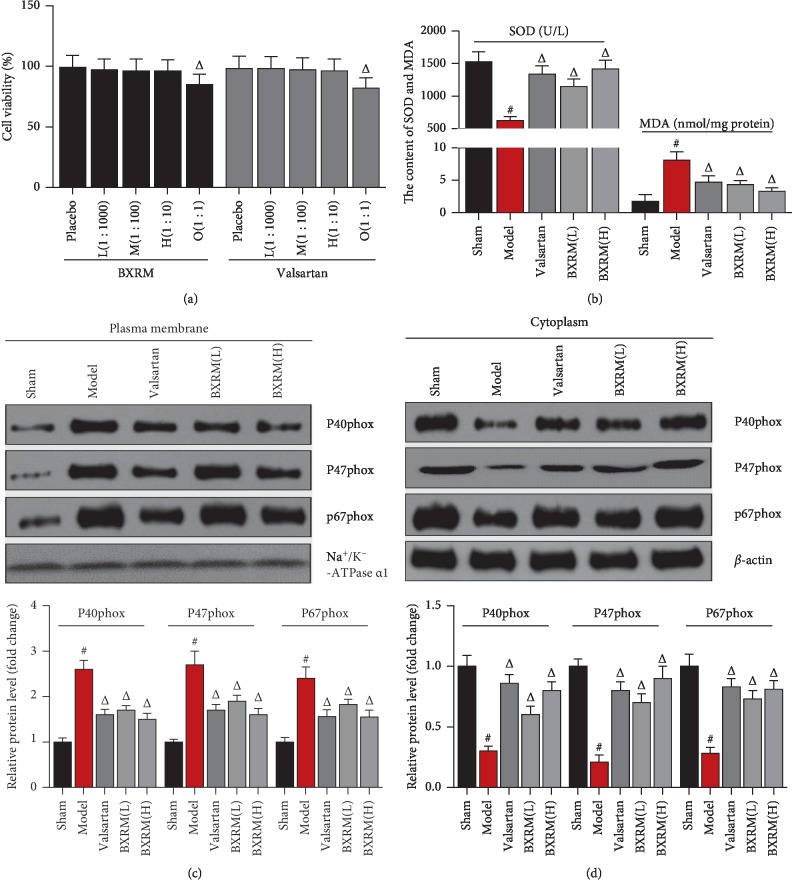
Effect of Granule of BU-XIN RUAN-MAI-containing serum on antioxidation and energy metabolism in angiotensin II-stimulated HUVEC cells. (a) The effect of Granule of BU-XIN RUAN-MAI on HUVEC cell viability. Data shown are mean ± SD; #P < 0.001 versus the placebo group. (b) Effect of Granule of BU-XIN RUAN-MAI-containing serum on the SOD content and MDA content in angiotensin II-stimulated HUVEC cells; data shown are mean ± SD; #P < 0.001 versus the sham group and ΔP < 0.05 versus the model group. (c) Effect of Granule of BU-XIN RUAN-MAI-containing serum on energy metabolism indicators (P40phox, P47phox, and P67phox) at the cell membrane detected by western blot in angiotensin II-incubated HUVEC cells and the corresponding semi-quantitative analysis was based on optical density with ImageJ software; data shown are mean ± SD; #P < 0.001 versus the sham group and ΔP < 0.05 versus the model group. (d) Effect of Granule of BU-XIN RUAN-MAI-containing serum on energy metabolism indicators (P40phox, P47phox, and P67phox) in the cytoplasm detected by western blot in angiotensin II-incubated HUVEC cells, and the corresponding semi-quantitative analysis was based on optical density with ImageJ software; data shown are mean ± SD; #P < 0.001 versus the sham group and ΔP < 0.05 versus the model group. The data are representative of three independent experiments.